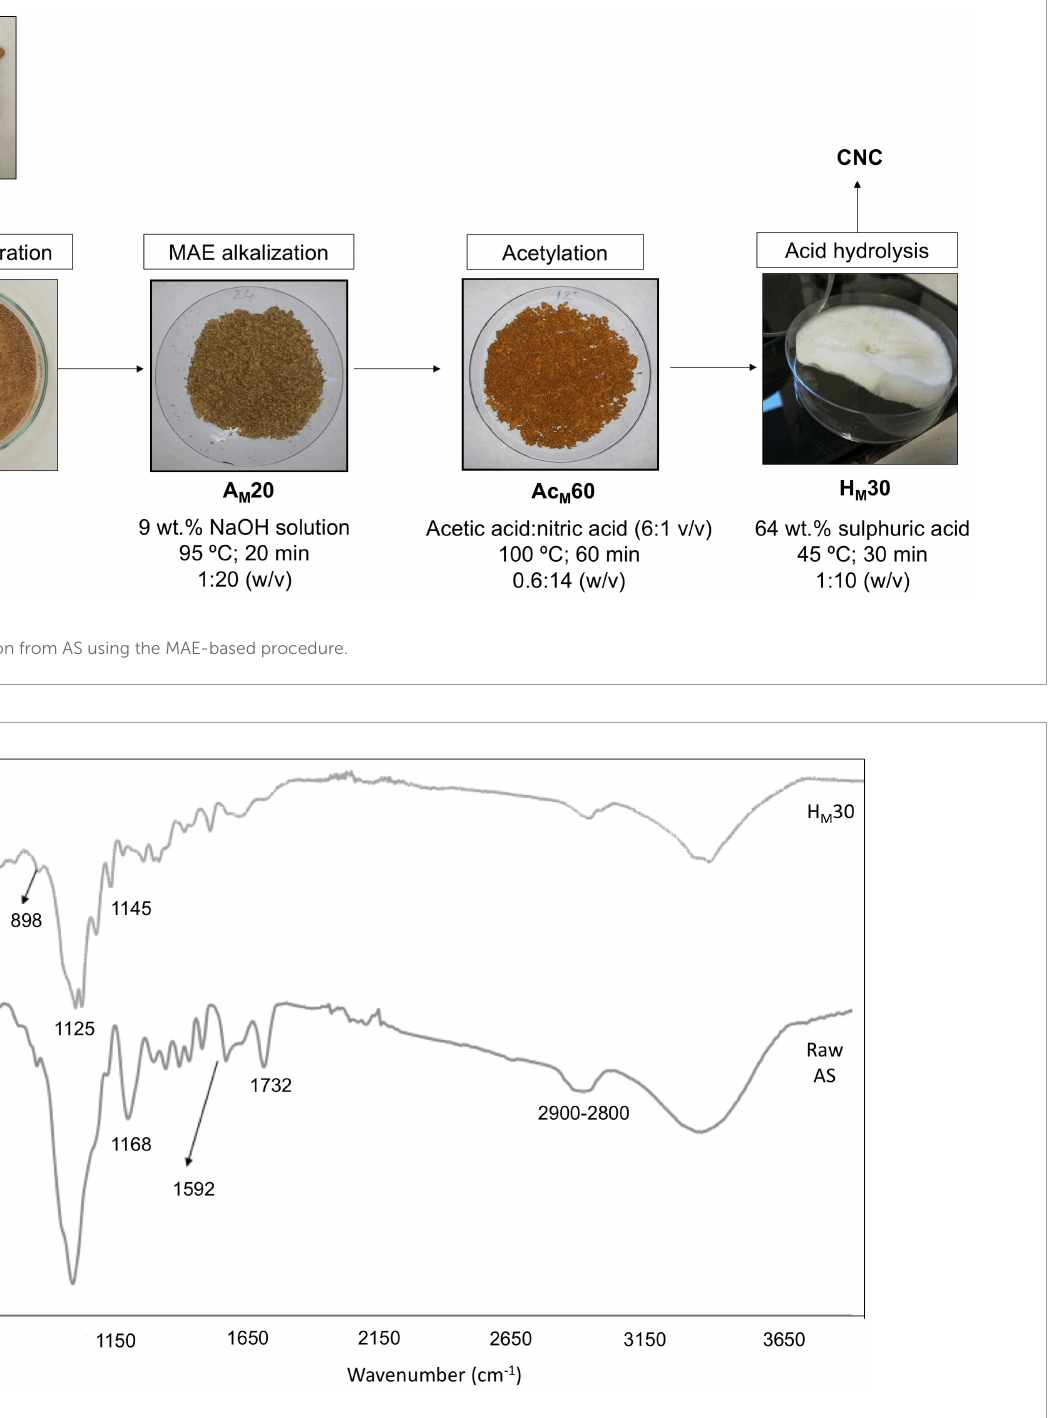
Frontiers in Nutrition